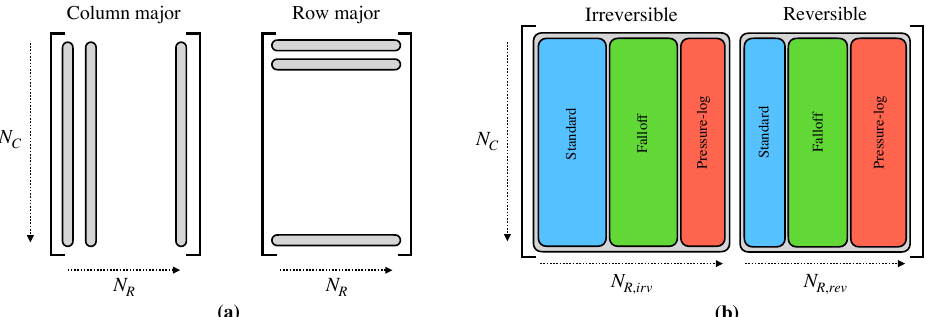
Figure 2. ( a ) Interpretations of a matrix in column major ( left ) and row major ( right ) formats. The gray shapes within the matrices show the storage method as a stacking of N R column vectors (for column major) or N C row vectors (for row major). ( b ) Decomposition of a reaction matrix into N R , irv irreversible and N R , rev reversible sub-matrices, each with another set of sub-matrices corresponding to standard, falloff, and pressure-log reaction